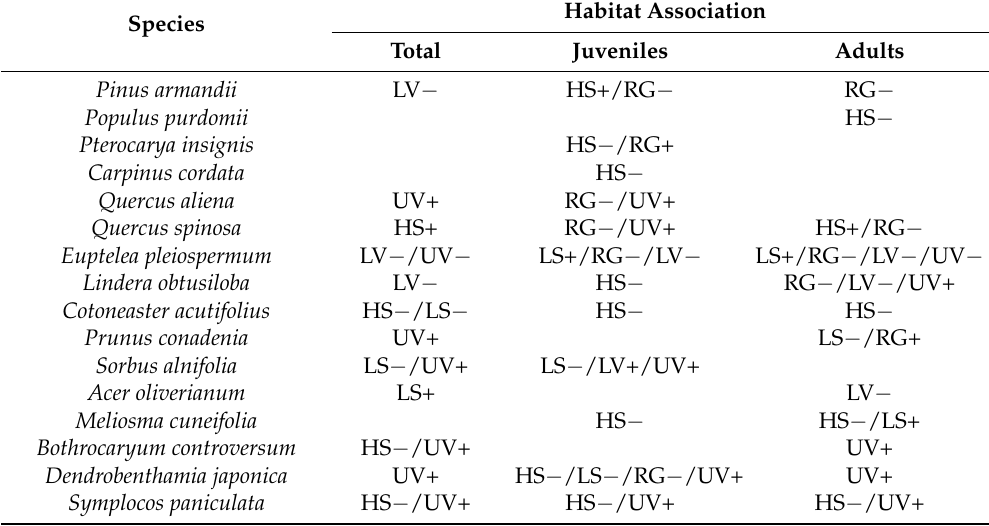
Table 2. Torus-translation test for habitat associations of the 16 dominant species in the 25-ha plot of the deciduous broad-leaved forest in the Qinling Mountains, north-central China. Total: All individuals with DBH ≥ 1 cm; Juveniles: Individuals with DBH < DBH99 1/2 ; Adults: Individuals with DBH > DBH99 2/3 . HS: high-slope, LS: low-slope, RG: ridge, LV: low-valley, UV: upper-valley. “+” represents significantly positive association, “ − ” indicates significantly negative association ( α =